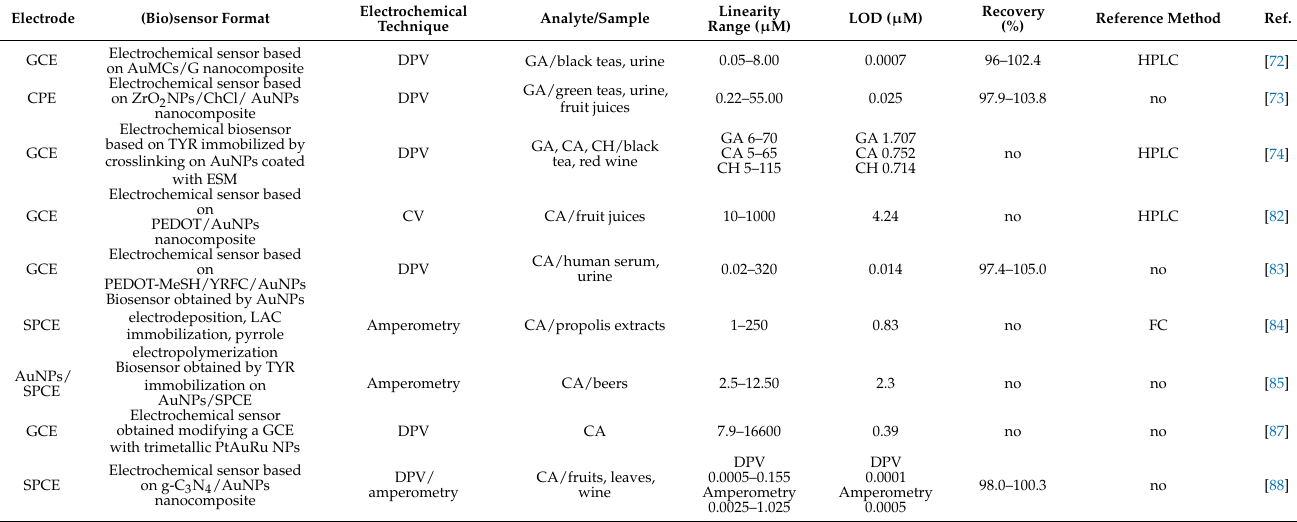
Table 1. Performances of electrochemical sensors for phenolic acid